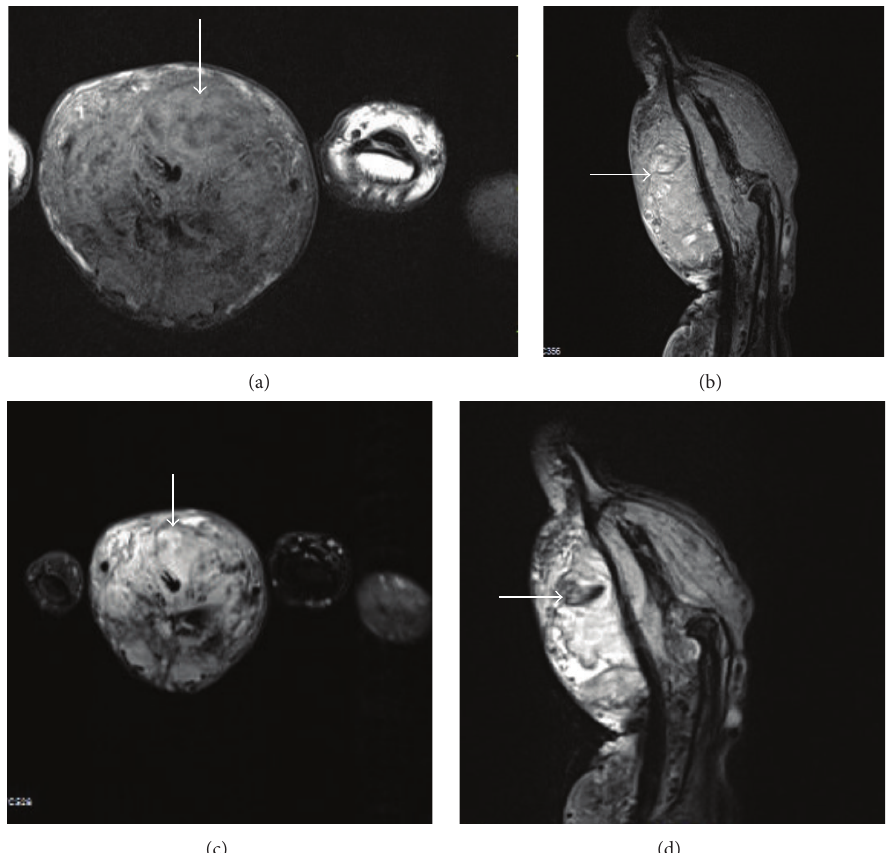
Figure 2: AVM. MRI (of the same patient as in Figure 1) shows a large heterogeneous T1W hypointense (a) and T2WFS hyperintense (b) lesion (arrows) showing few intralesional flow voids, marrow extension, and cortical breech. On post contrast T1WFS sequences ((c), (d)) the lesion shows intense heterogeneous postcontrast enhancement